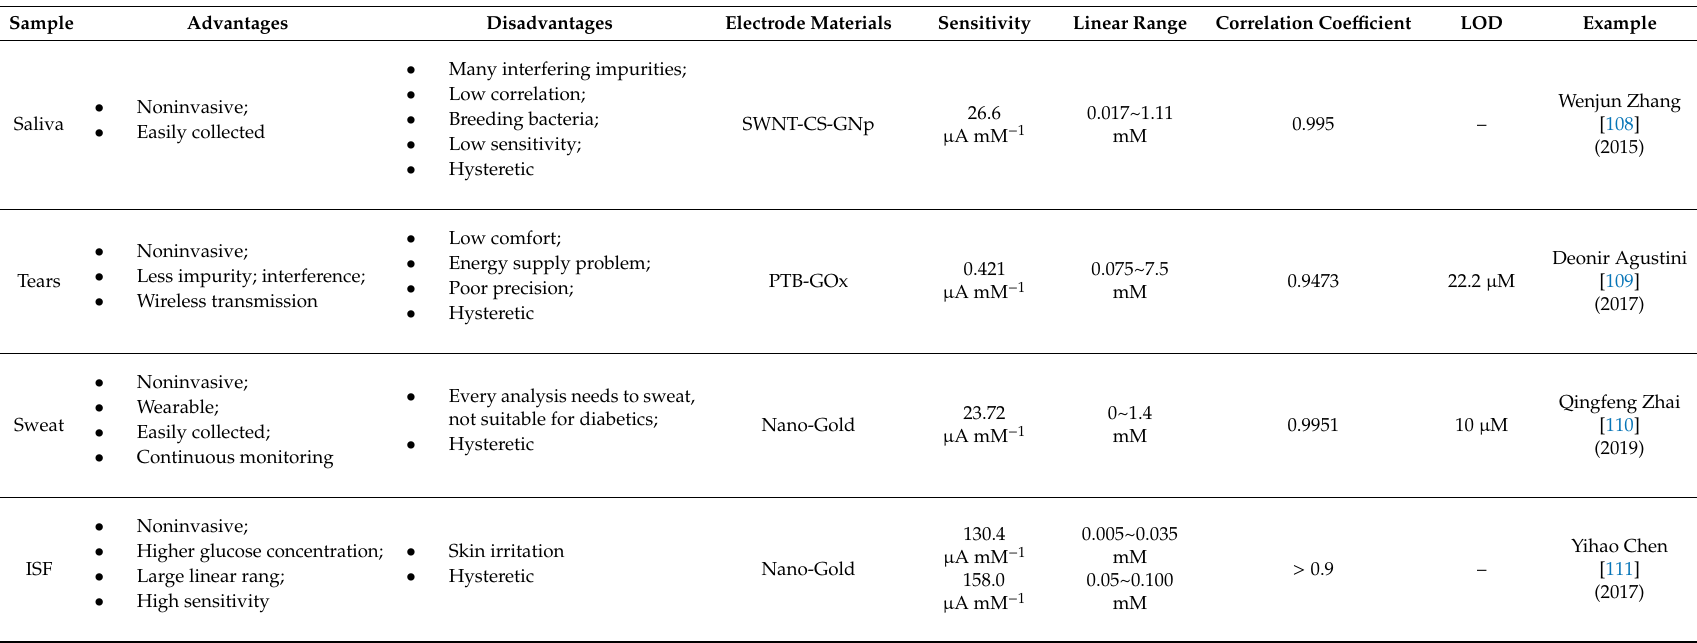
Table 1. Saliva, tears, sweat and interstitial fluids (ISF)-based glucose monitoring devices comparison.